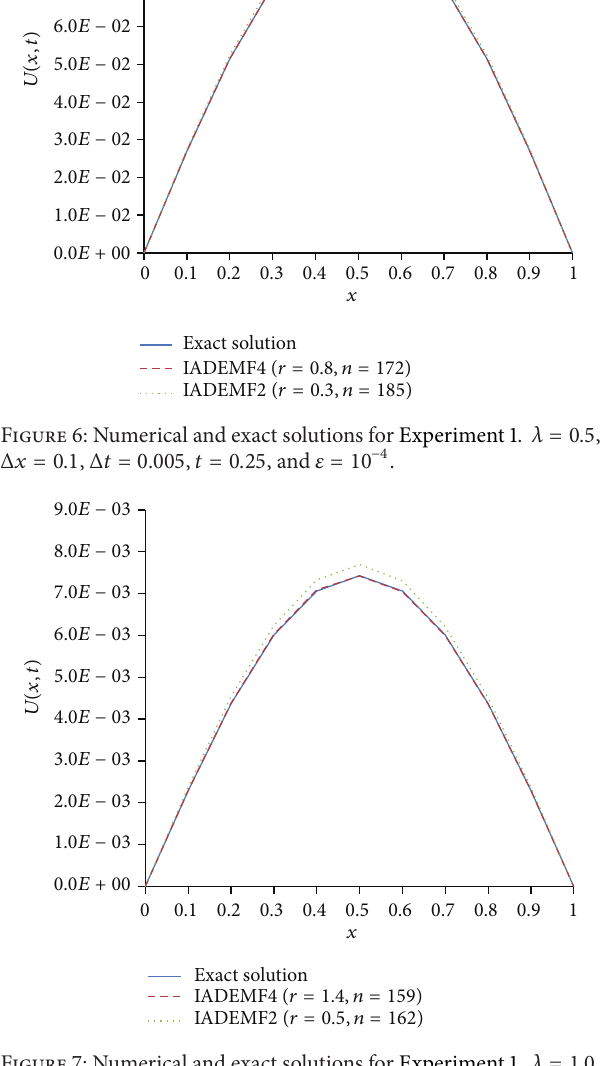
ten times bigger (𝑚 = 7000) and a more stringent tolerance −10 ) criterion was set (𝜀 = 10 , the accuracy of the